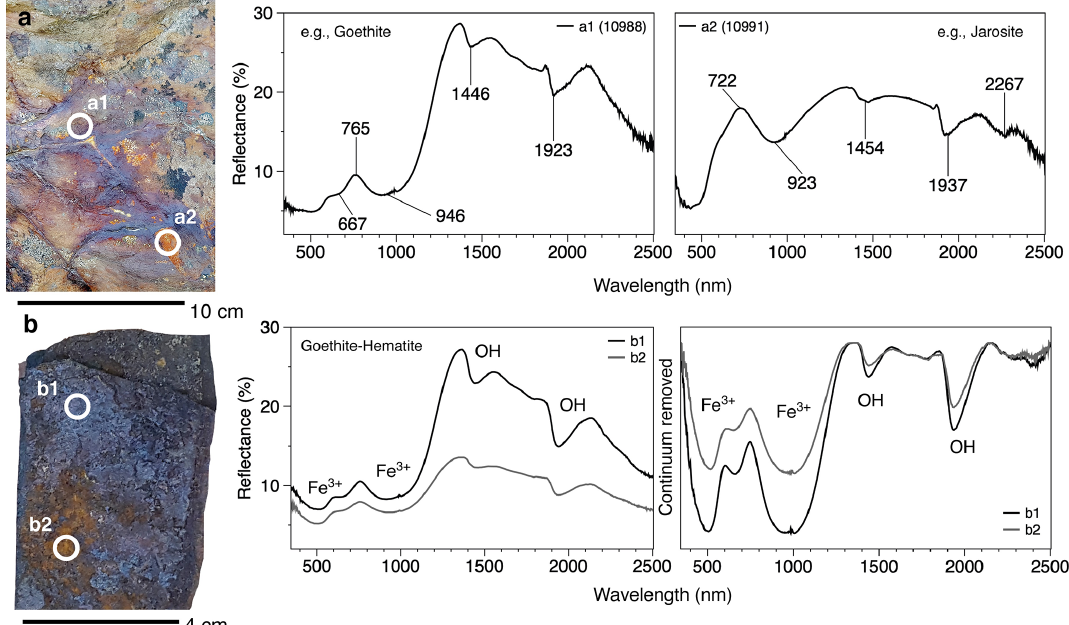
Figure 9. Spectral measurements taken on a basaltic outcrop that correlates with the magnetic anomaly E in Fig. 4, with further remote sensing and magnetic characteristics shown in Fig. 12a, b (see close-up location in Fig. 12e). (a) The rock surface shows iron-staining and absorption patterns typical for iron oxide and iron hydroxide (plotted absorption positions taken from Crowley et al., 2003). (b) Spectra ( b 1, b 2) from a sample (GEUS567321) which was scanned under laboratory conditions. Reflectance spectra (left plot) and continuum removed spectra (right plot) highlight the Fe- and the OH-related absorption